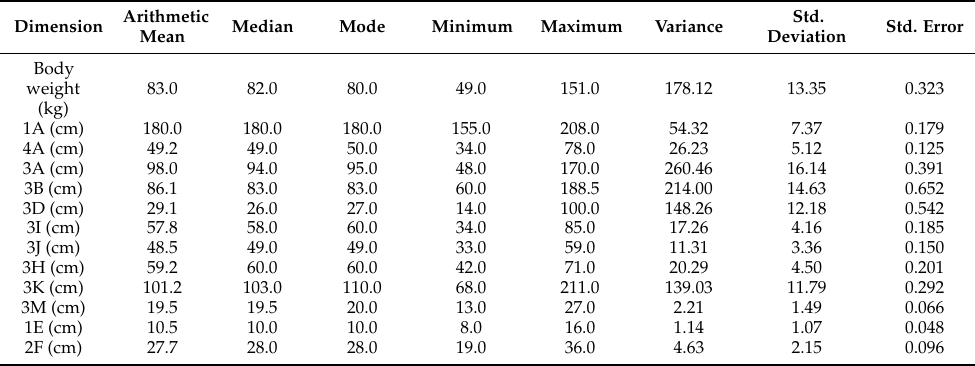
Table 1. Descriptive statistics from the analyzed population for anthropometric dimensions according to EN ISO 3411 during